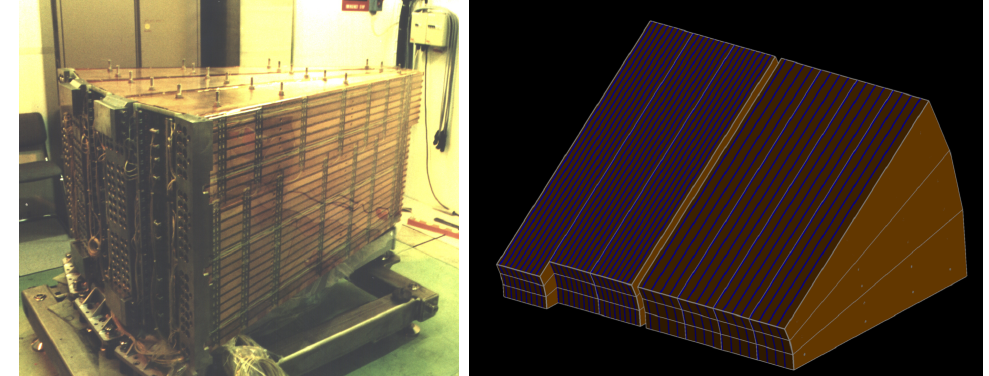
Figure 1. Left : Picture of three φ -modules from a section of the ATLAS HEC first wheel from [13]. Right : Graphical representation of the three φ -modules from a section of the ATLAS HEC, as simu- lated with